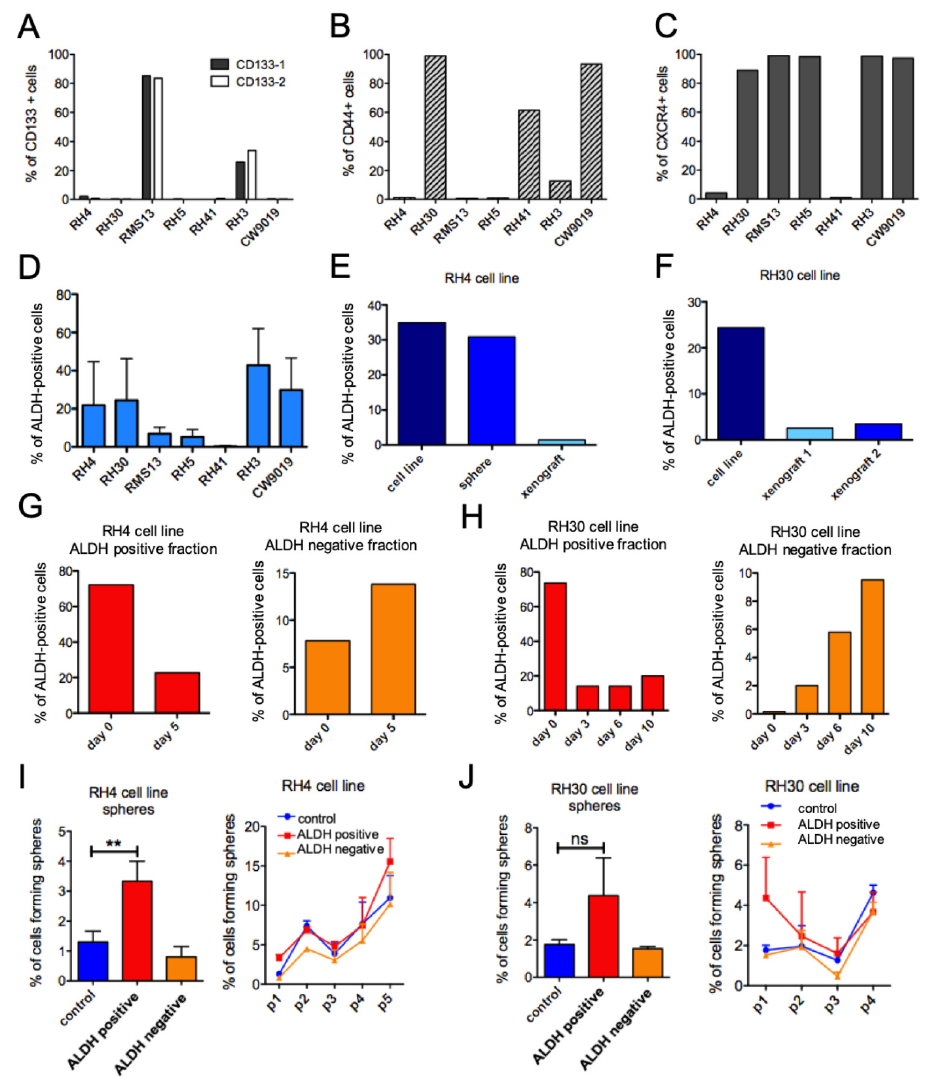
Figure 2. Lack of subpopulations with cancer stem ‐ like properties in FPRMS cells lines. ( A – C ) Flow cytometric analysis of CSC markers CD133 (epitope 1 and epitope 2), CD44, and CXCR4 in seven FPRMS cell lines. Percentage of positive cells is indicated. ( D ) Percentage of ALDH ‐ positive cells after staining with Aldefluor and flow cytometric analysis in FPRMS cell lines. ( E , F ) Percentage of ALDH ‐ positive cells after staining with Aldefluor in RH4 ( E ) and RH30 ( F ). FPRMS cells cultured as a monolayer (cell line), or under sphere conditions, or cells dissociated from xenografts. G, H Distribution of sorted ALDH ‐ positive and ‐ negative fractions in RH4 ( G ) and RH30 ( H ) cell lines after indicated days of culture. ( I , J ) Sphere assay with RH4 and RH30 sorted ALDH ‐ positive, ‐ negative, and control fractions (control fractions were unstained cells processed through the FACS machine and collected without sorting for specific subpopulations). Cells were cultured at clonal density in ALL ‐ sphere medium and primary sphere formation as well as self ‐ renewal ability over 5 passages (p) was quantified. (unpaired t ‐ test: ** p < 0.005, ns: not significant).